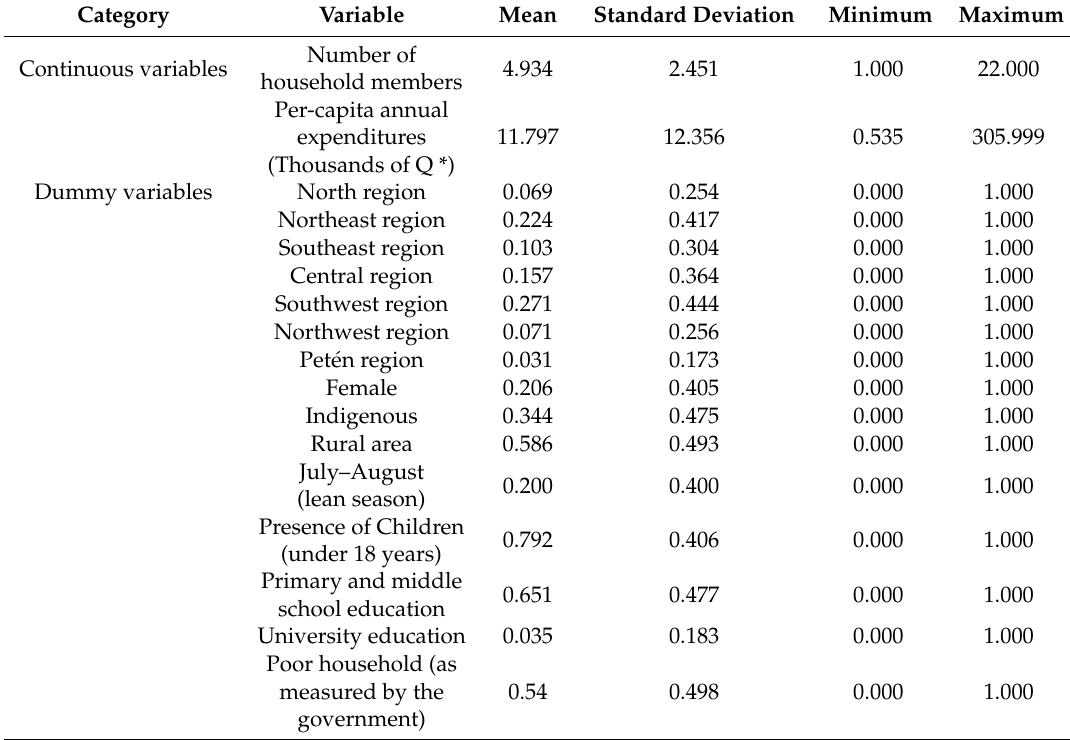
Table 2. Explanatory variables for the logistic regression